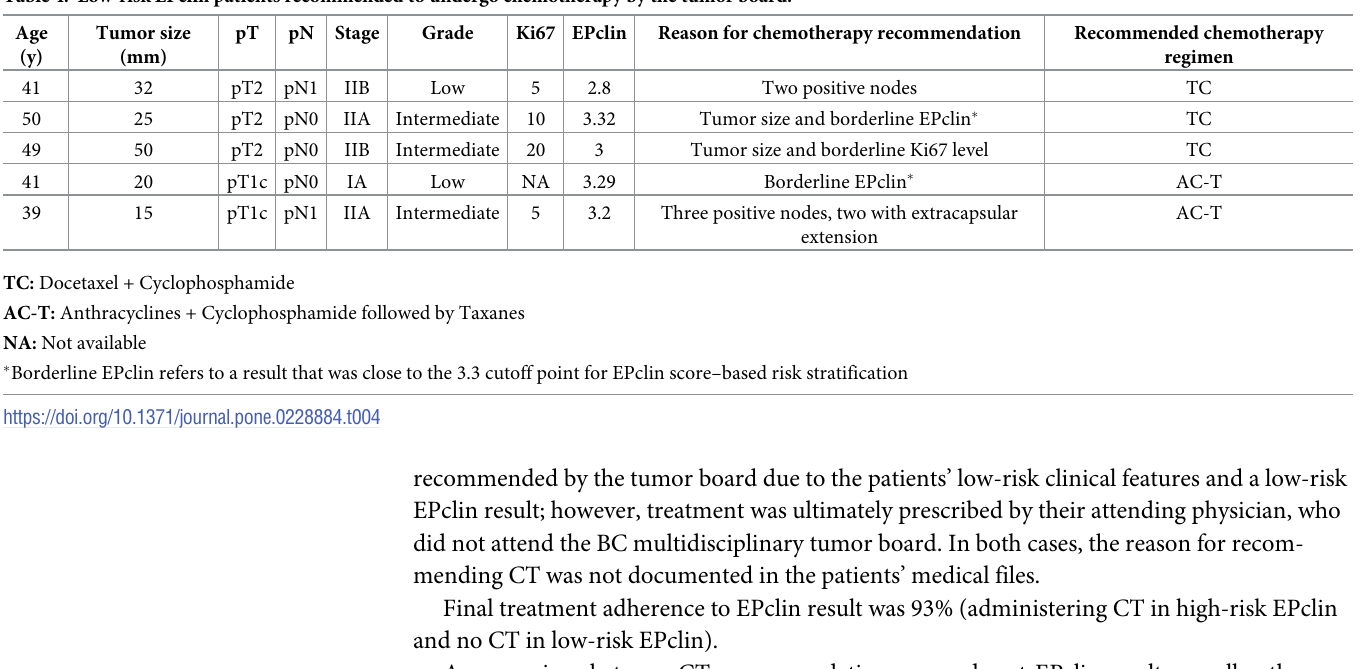
mending CT was not documented in the patients’ medical files.